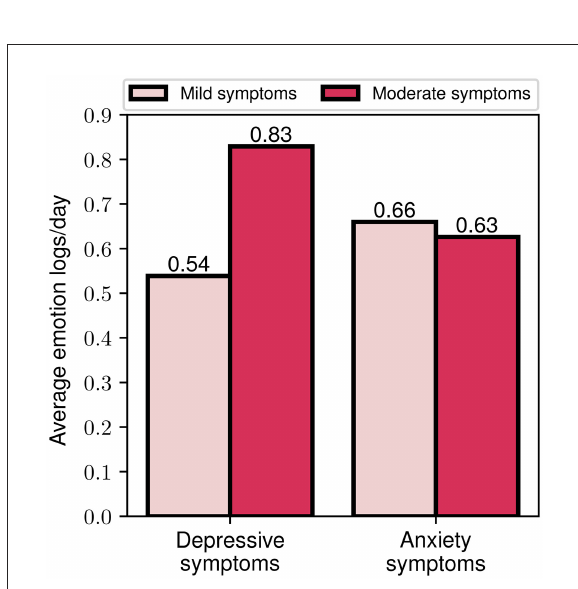
FIGURE10 Average emotion logs per day for mild and moderate depressive and anxiety symptoms baseline assessment.